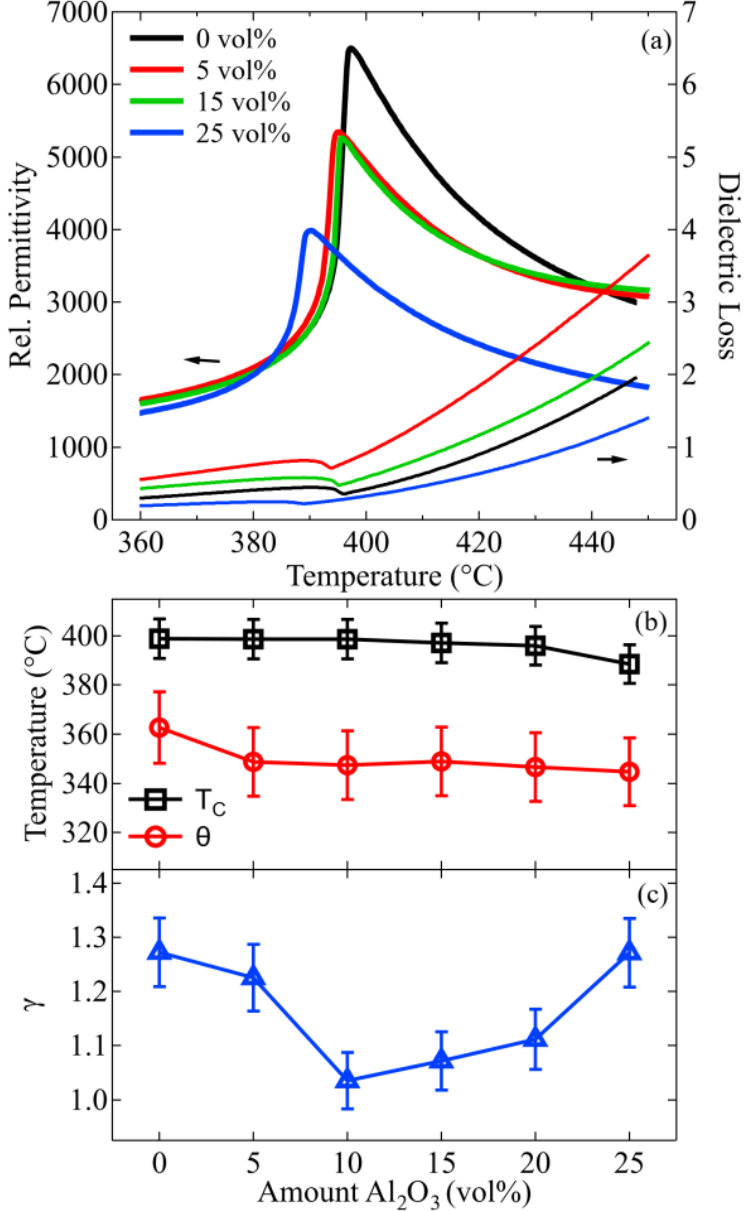
Figure 1. Relative permittivity and dielectric loss between 360 °C and 450 °C for NKN with specific vol% Al 2 O 3 ( a ). Shift of Curie point and Curie–Weiss temperature ( b ) and measured exponent γ in Equation (7) ( c ) of NKN as a function of vol% Al 2 O 3 .